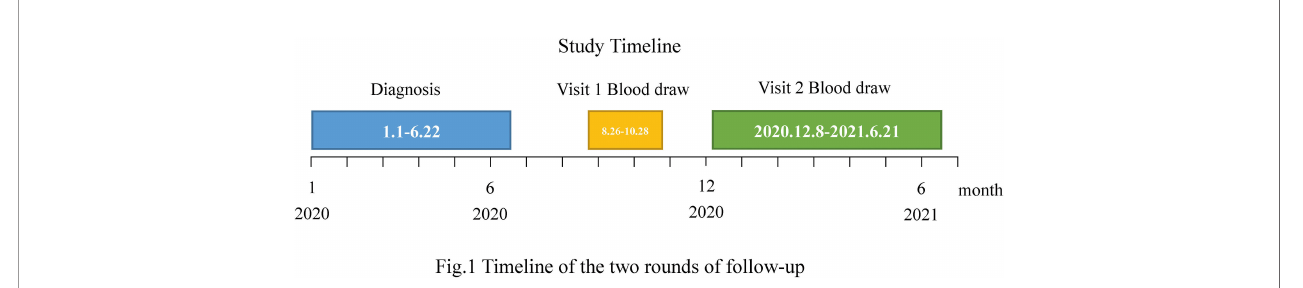
FIGURE 1 | Timeline of the two rounds of follow-up. A total of 402 COVID-19-cured patients (con fi rmed from January to June 2020) participated in the follow-up visits. Of these, 284 underwent the fi rst round of follow-up (blood draw period from 26 August to 28 October 2020) and 318 participated in the second round